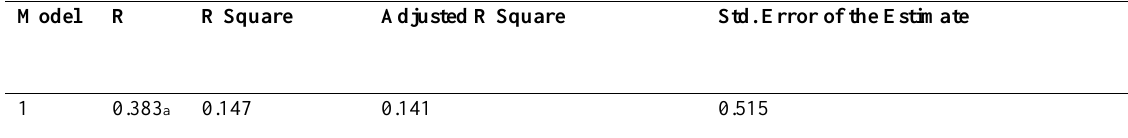
Table 6: Regression Model summary for support service linkage and sustainability of